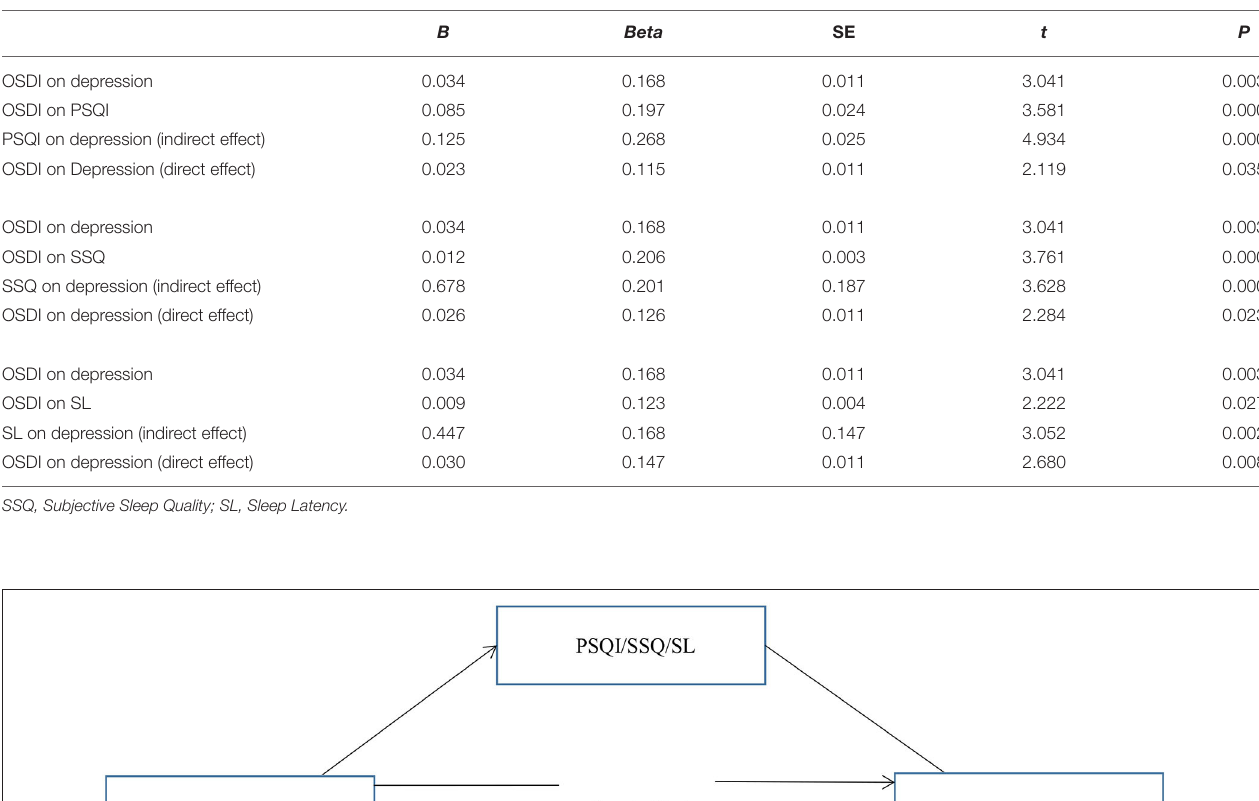
TABLE 5 | Mediation analysis of PSQI,SSQ,SL on the relationship between the OSDI and depression.